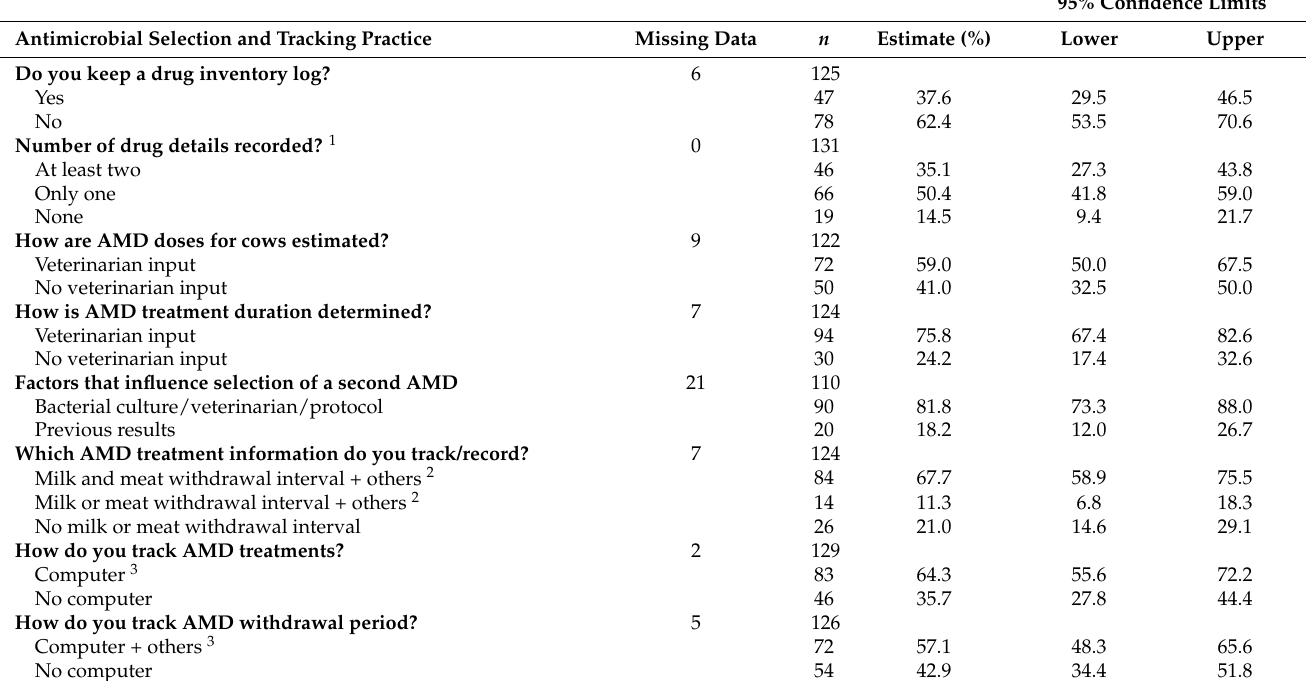
Table 5. Summary of responses to questions about antimicrobial drug (AMD) selection and tracking practices from responses to questionnaire on AMD use in adult cows on California dairies during